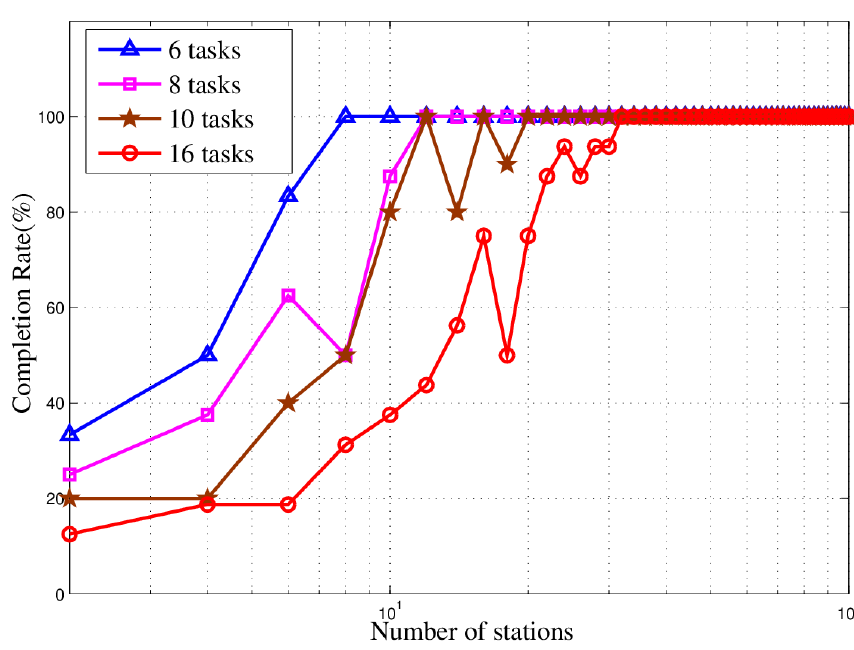
Figure 21. Completion rate curve in different scenarios.